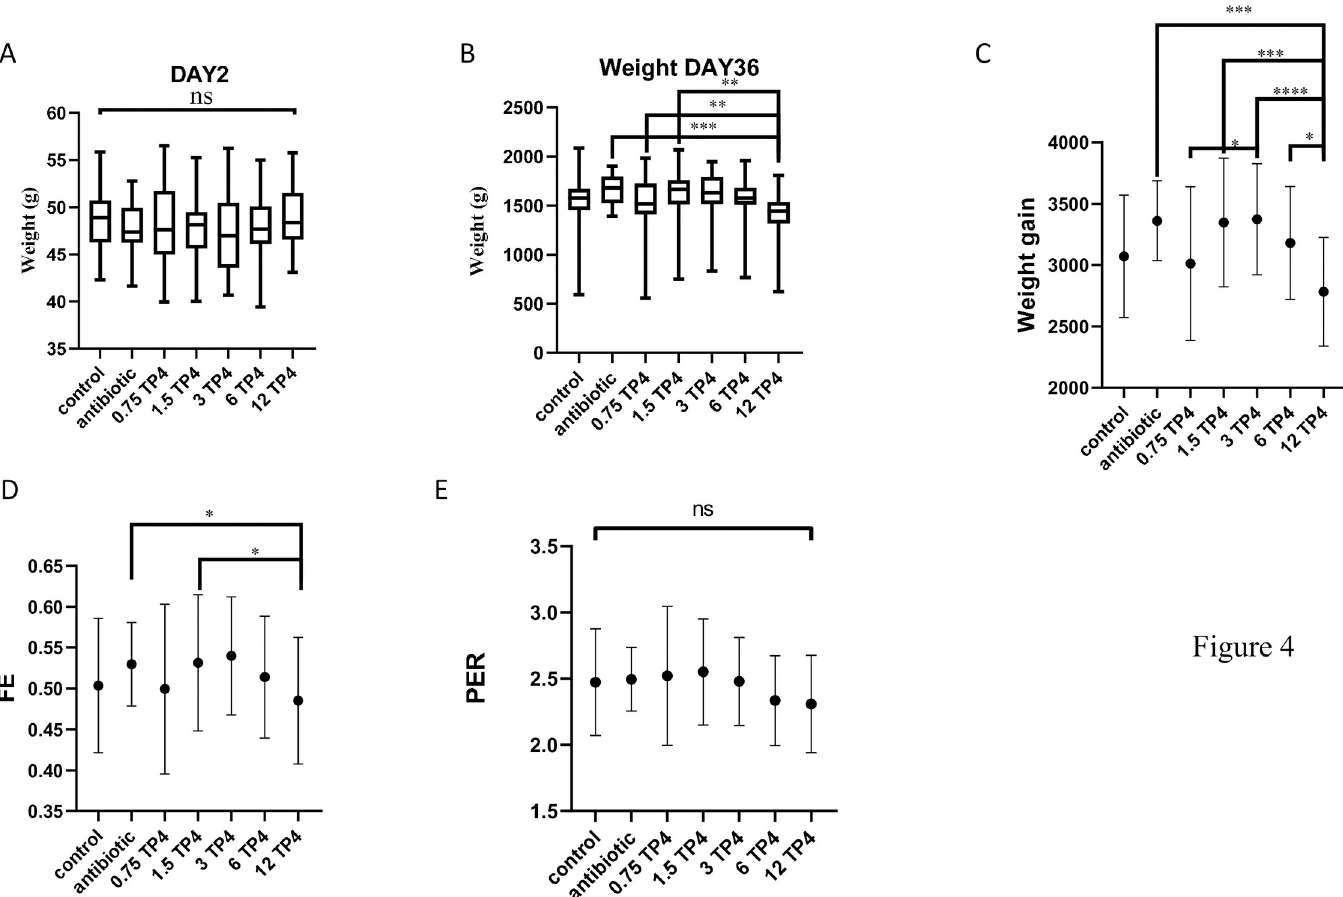
Fig 4. Effect on feed parameter analysis. (A) Weight for day 2 and (B) day 36 analysis between groups. (C) weight gain, (D) FE (feed efficiency), and (E) PER (protein efficiency ratio) of G . g . domesticus fed diets containing rTP4 (0.75, 1.5, 3.0, 6.0 or 12%) spray-dried powder for 5 weeks. Each bar represents the mean value from three determinations, with the standard error (SE). Data (mean ± SE) with star marker represent differ significantly (P < 0.05) among treatments.